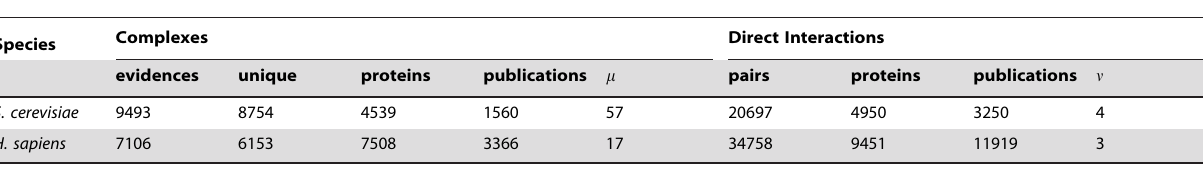
Table 1. Initial Datasets of Complexes and Direct